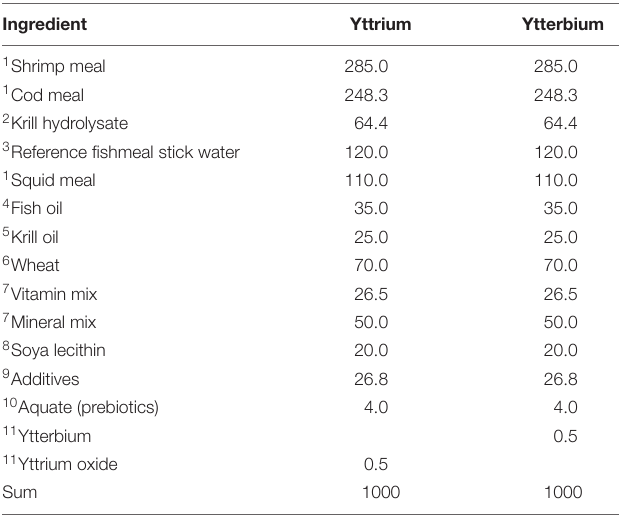
TABLE 1 | Experimental fish diet formulations, g kg − 1 dry matter.